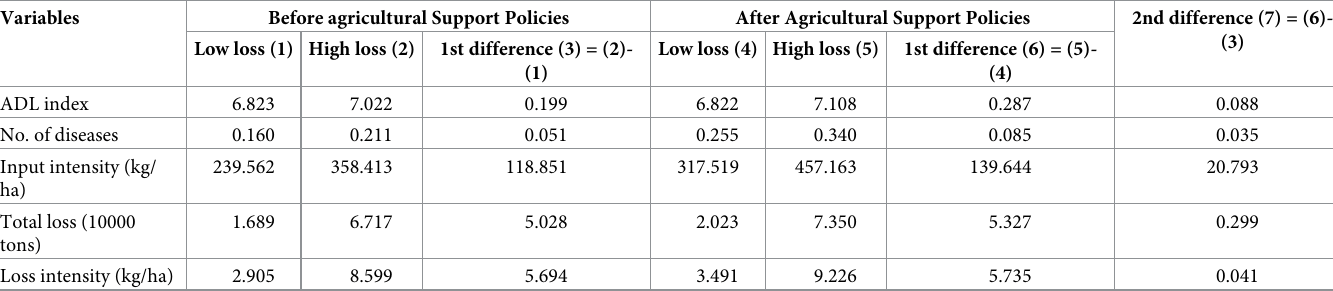
Table 2. Comparison of high-loss-areas and low-loss areas by agricultural support policies. Variables